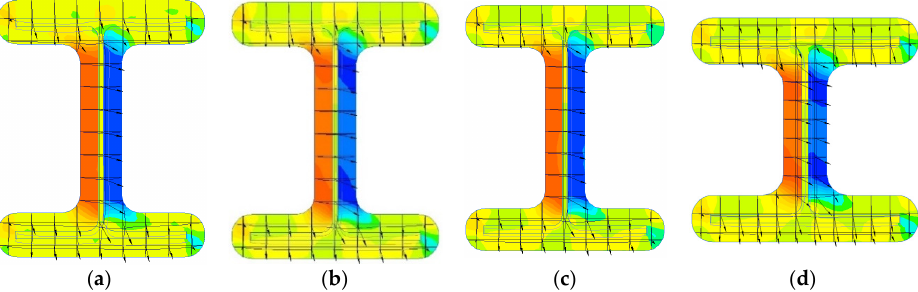
Figure 12. Visualization of changed shape and displacement vectors under combined mechanical and thermal loads for samples No. 1.1 ( a ), No. 1.2 ( b ), No. 1.3 ( c ) and No. 3.1 and No. 3.2 ( d ). To determine the value of the ultimate vertical deformation at the end of the fire exposure, a section model of steel I-beams with coatings No. 1.1–No. 1.3, No. 3.1 and No. 3.2 was built in SP ELCUT (Figure 13). Deformation values for the height of steel I-beams are shown on the right side of the sample.